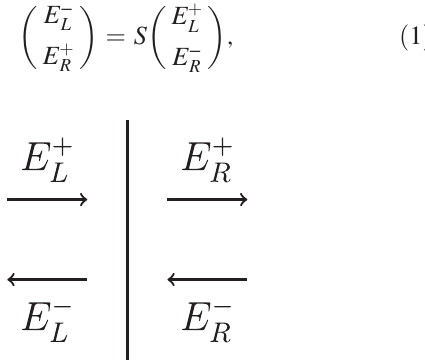
FIG. 5. Representation of the electric field components on the left ( L ) and right ( R ) sides of an interface, together with the propagation directions from left to right ( þ ) and right to left ( −